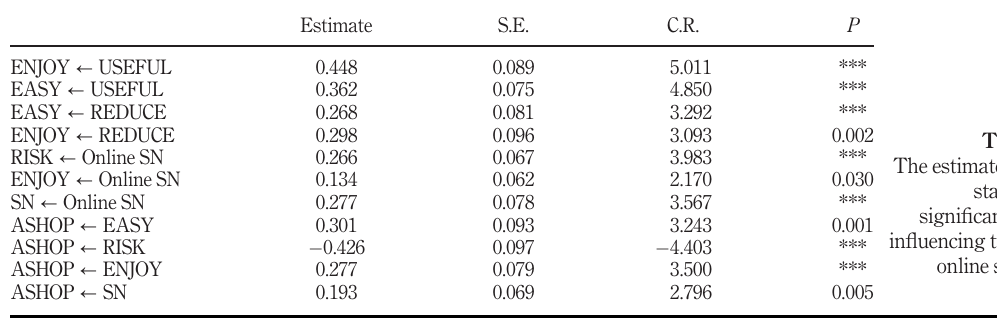
Table IV. The estimates for